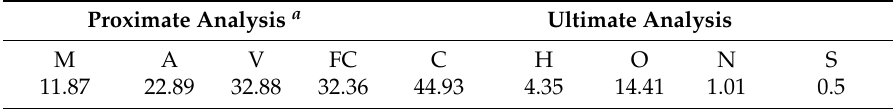
Table 1. Proximate and ultimate analyses of Shenbei lignite (wt %, air-dried basis). Proximate Analysis a Ultimate Analysis M